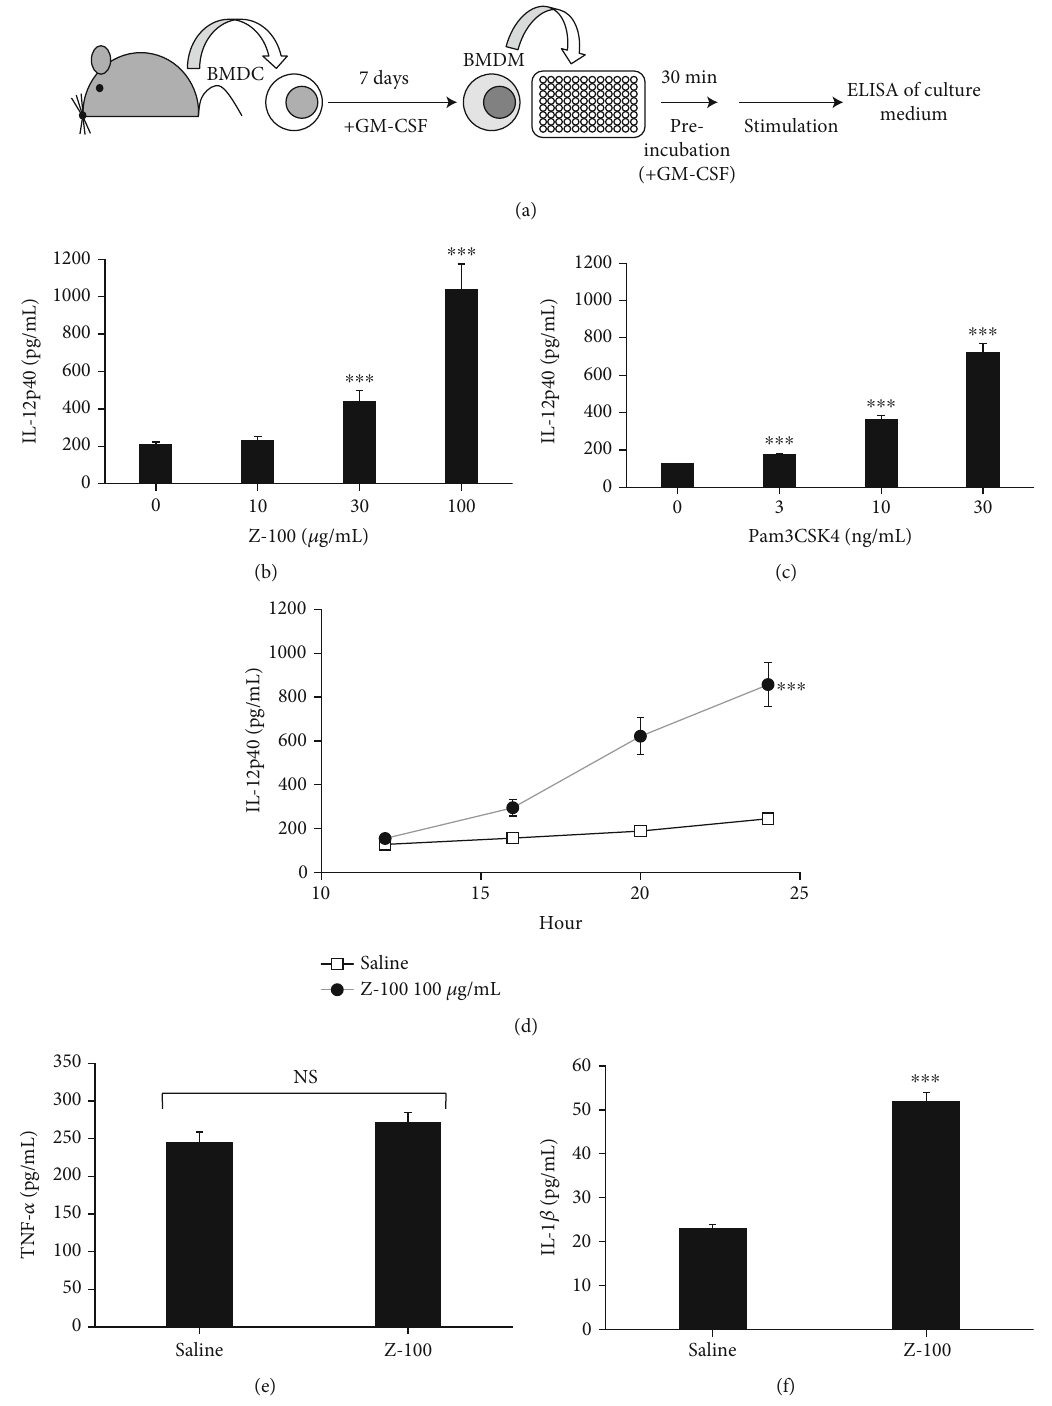
Figure 1: Cytokine production from BMDM following Z-100 stimulation. (a) Schematic of the experimental design. Bone marrow-derived cells were cultured with GM-CSF for 7 days before being seeded onto plates and preincubated for 30 minutes. After preincubation, stimulation was started. (b, c) IL-12p40 concentration in culture supernatant of BMDM after stimulation for 24 hours with Z-100 (b; 10, 30, or 100 μ g/mL) or Pam3CSK4 (c; 3, 10, or 30ng/mL). Symbols indicate a signi fi cant di ff erence compared with the 0 μ g/mL (saline) group; ∗∗∗ P < 0 : 001 (Steel ’ s multiple comparisons test). (d) Time course of IL-12p40 production induced by Z-100 (100 μ g/mL). Symbols indicate a signi fi cant di ff erence compared with the saline group; ∗∗∗ P < 0 : 001 (repeated measures ANOVA). (e, f) TNF- α (e) and IL-1 β (f) concentration in the culture supernatant of BMDM after stimulation for 24 hours with Z-100 (100 μ g/mL). Symbols indicate a signi fi cant di ff erence compared with the saline group; ∗∗∗ P < 0 : 001 (Student ’ s t -test). Data show the mean ± S : E : ; n = 12 per group, pooled from 3